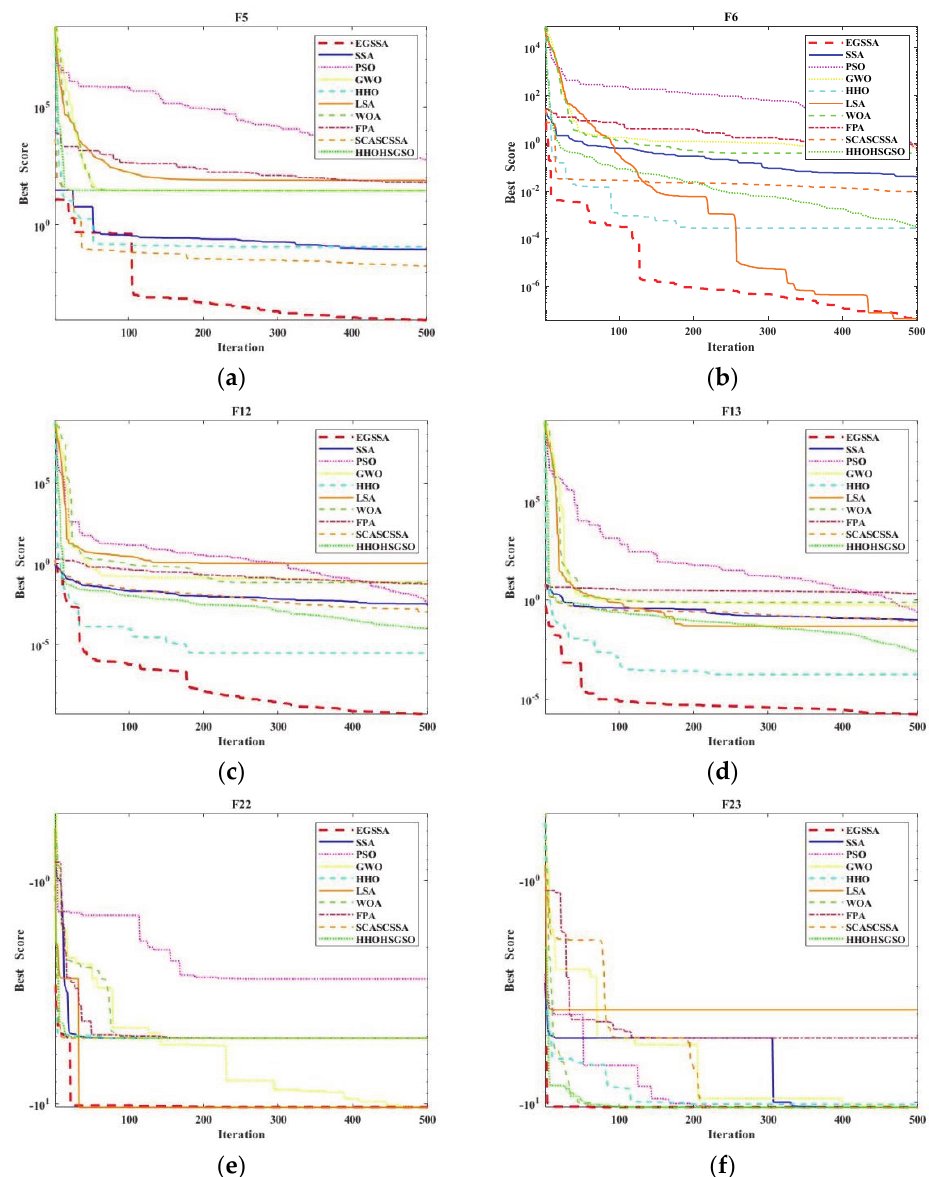
Figure 4. The convergence curves of EGSSA and other algorithms. ( a ) the convergence curves on F5; ( b ) the convergence curves on F6; ( c ) the convergence curves on F12; ( d ) the convergence curves on F13; ( e ) the convergence curves on F22; ( f ) the convergence curves on F23.